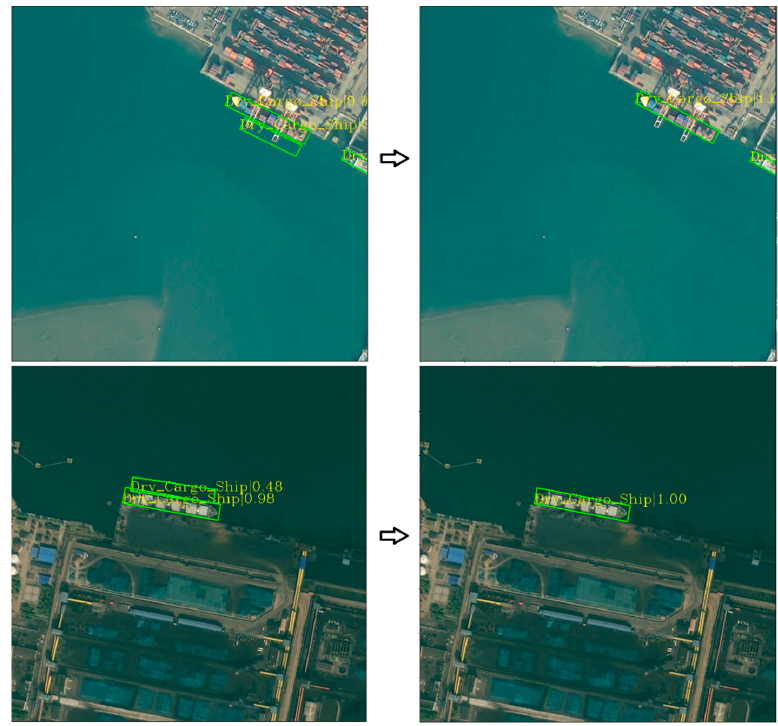
Figure 16. Detection effect of model before and after adding ECA.